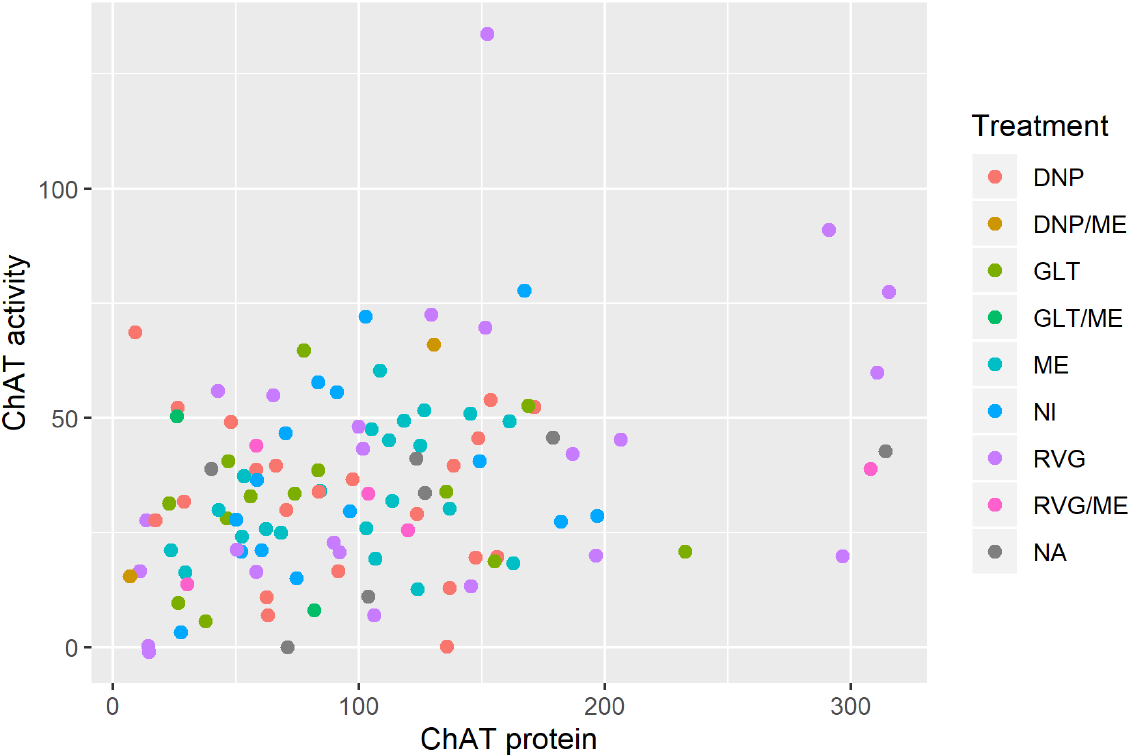
Figure 1 – Comparisons of the ChAT protein and activity of soluble ChAT in plasma of patients with Alzheimer’s disease (AD), according to the treatment type. NA: no information; NI: do not use medicine; ME: memantine; DNP: donepezil; GLT: galantamine; RVG: